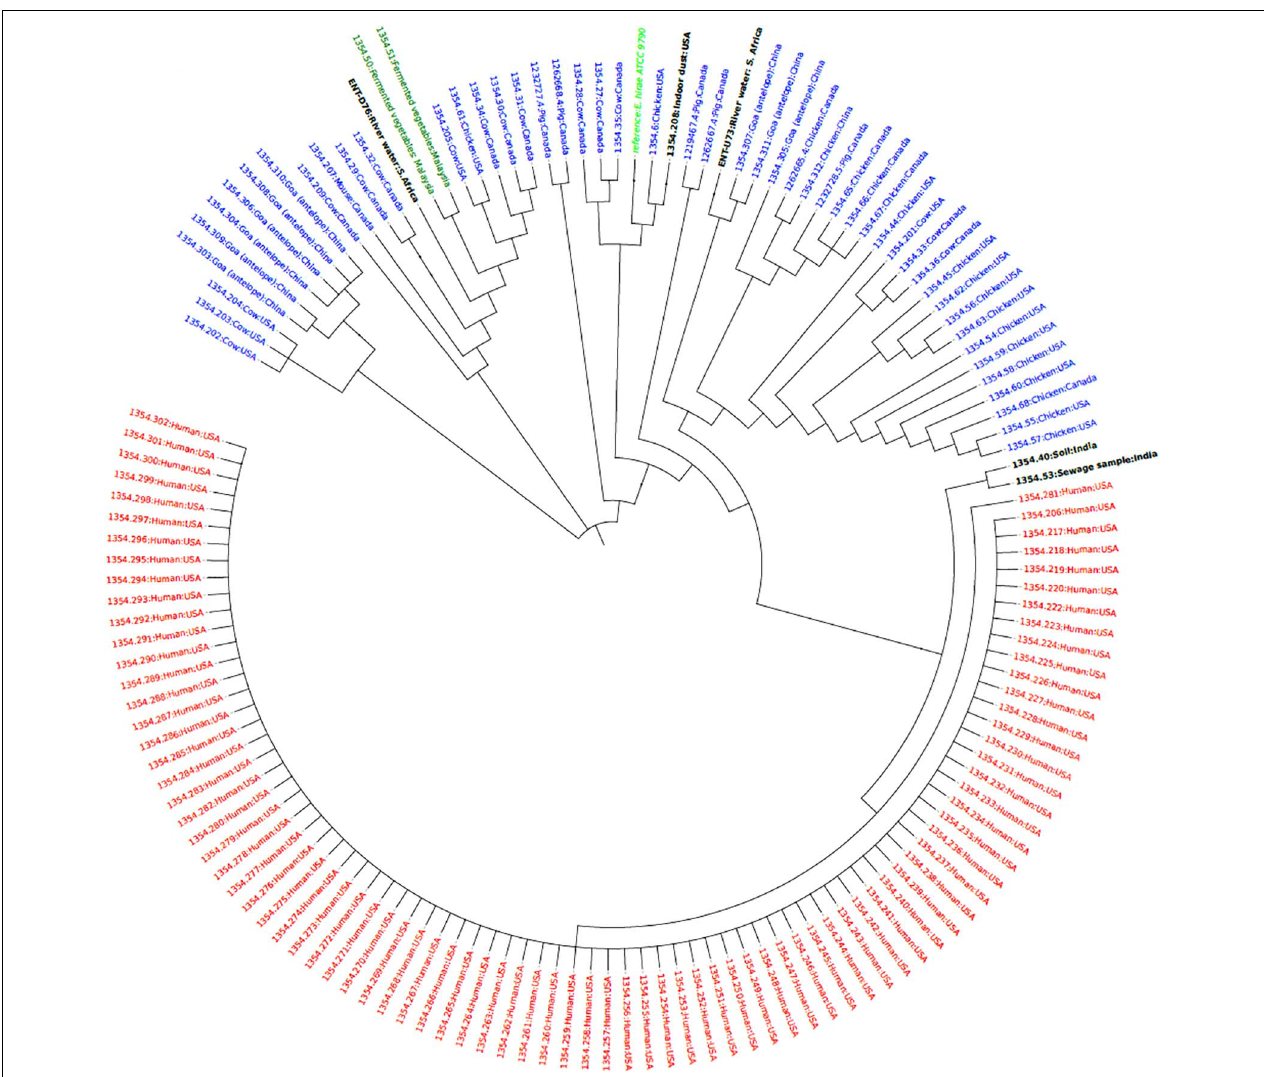
FIGURE 3 | Phylogenetic tree based on SNP differences in the core genomes of E. hirae isolates from this study (ENT D76 and ENT U73) and other isolates from humans (red), animals (blue), environment (black) obtained from the PATRIC database